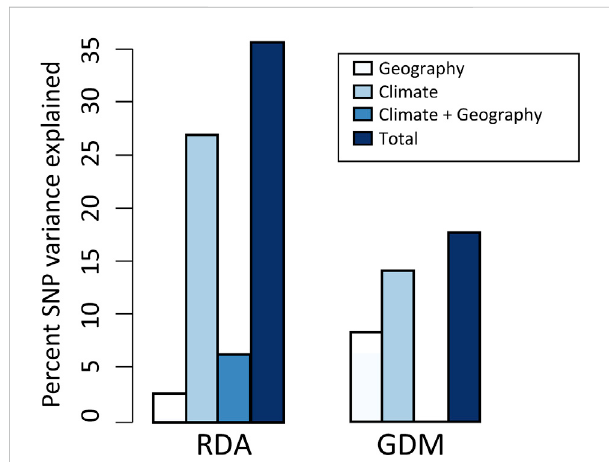
FIGURE 3 Results of variance partitioning estimated by RDA and GDM models. The total in legend means the genetic variation that climate and geography jointly explained, and the climate + geography means the collinear part of genetic variation. Note that GDM cannot estimate the contribution of climate +